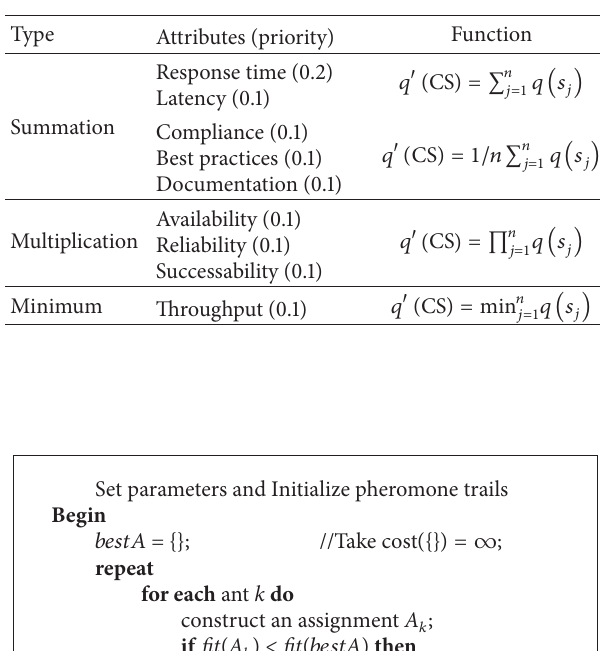
Table 1: The considered attributes, their priorities, and aggregation